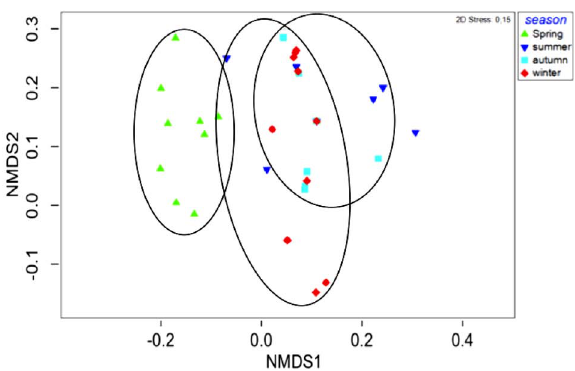
Fig. 3. – Non-parametric multidimensional scaling (NMDS) plots of fish larvae in different season in the Lezíria salt marsh creek. (NMDS) plots based on triangular matrices of Bray-Curtis similari- ties using species abundance